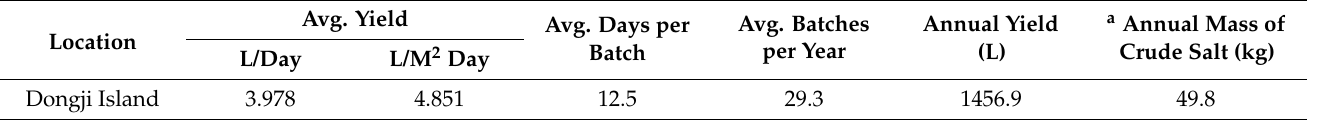
Location Table 10. Predicted annual yield of potable water and crude sea salt production. Avg. Yield Avg. Days per Location